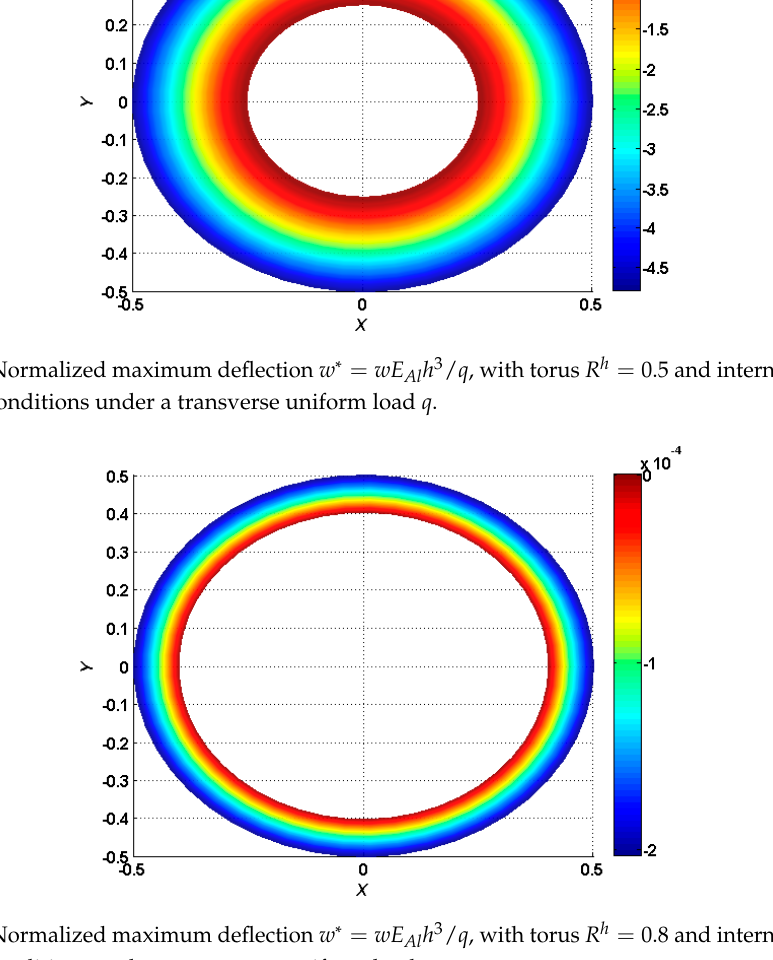
w wE h q = with torus 0.8 h R = and internal Al ,